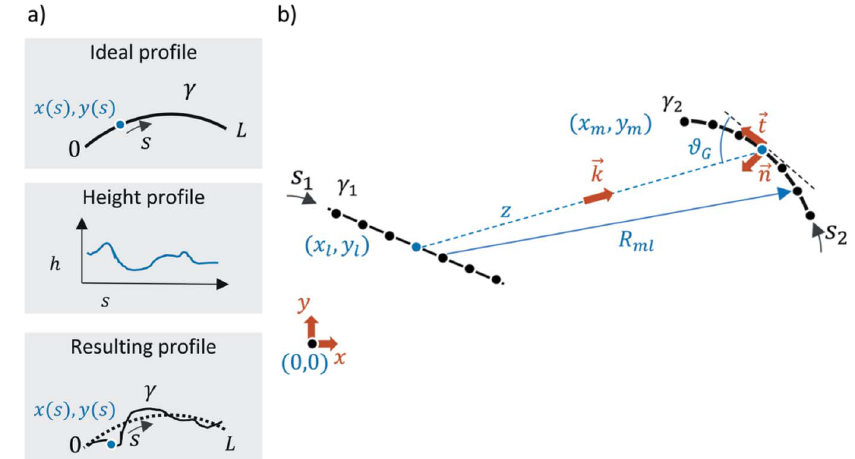
Figure 2 ( a ) Top: an ideal surface profile (cid:7) representing an optical element. Middle: height profile as a function of s . Bottom: the summation of the two. ( b ) The propagation from (cid:7) 1 to (cid:7) 2 . The output wavevector k is defined by the reflection on the ideal profile, without considering any height profile superimposed on